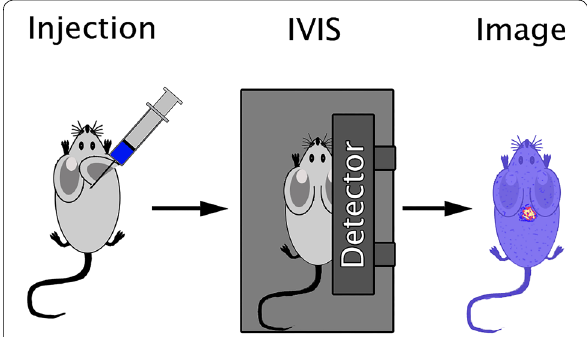
Fig. 1 Schematic representation of the in vivo fluorescence imaging experiment. A dose of a sulfo-Cy5 labeled drug is injected subcutaneously between the shoulder blades of the mouse, the animal is imaged using the in vivo imaging system (IVIS), and a 2D fluorescence image of the mouse is